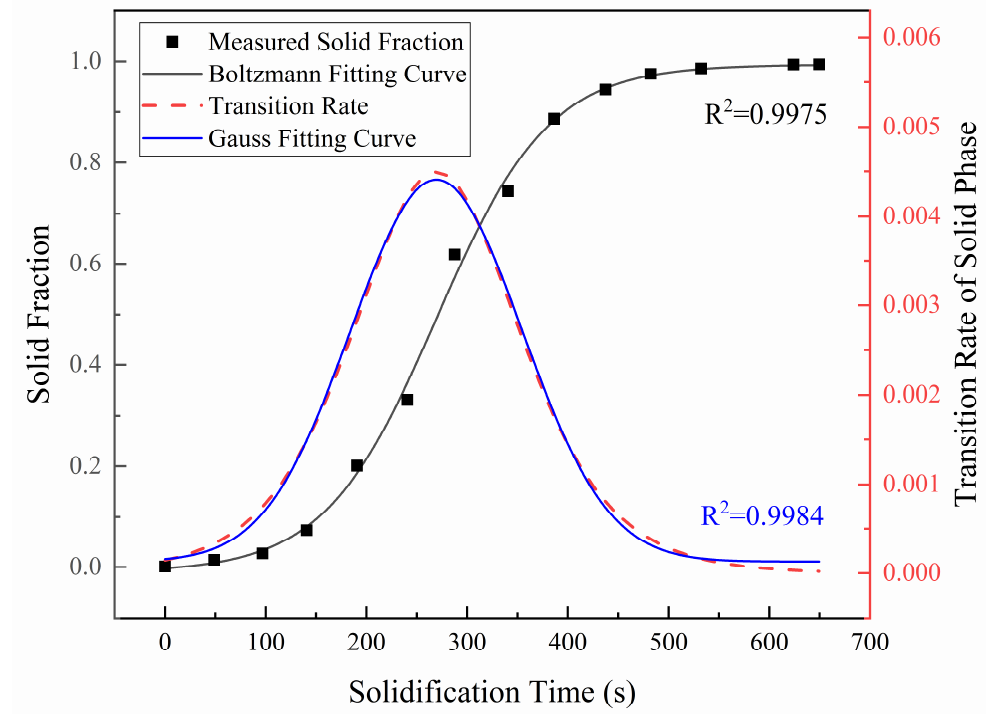
Figure 3. The variation trend of the solid fraction and the transition rate of the solid phase with solidification time.